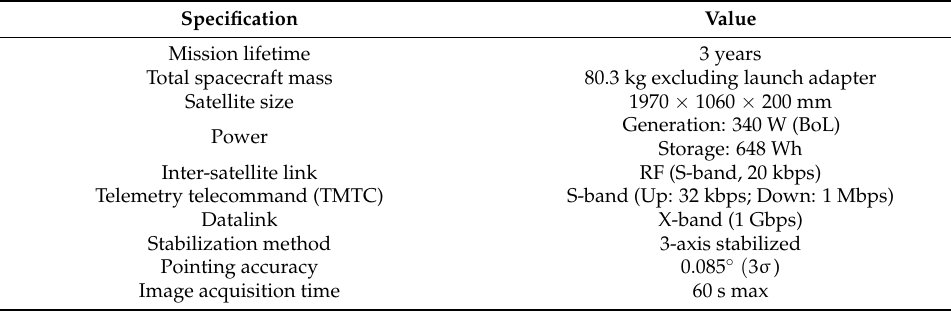
Figure 4. Mechanical configuration of the S-STEP satellite viewed from the ( a ) solar-panel side and ( b ) SAR-antenna-panel side. Patches appearing in the SAR antenna in ( b ) are schematic representa- tions for understanding. In an actual SAR antenna, the applied inverted patches are invisible. Table 1. S-STEP satellite system specifications